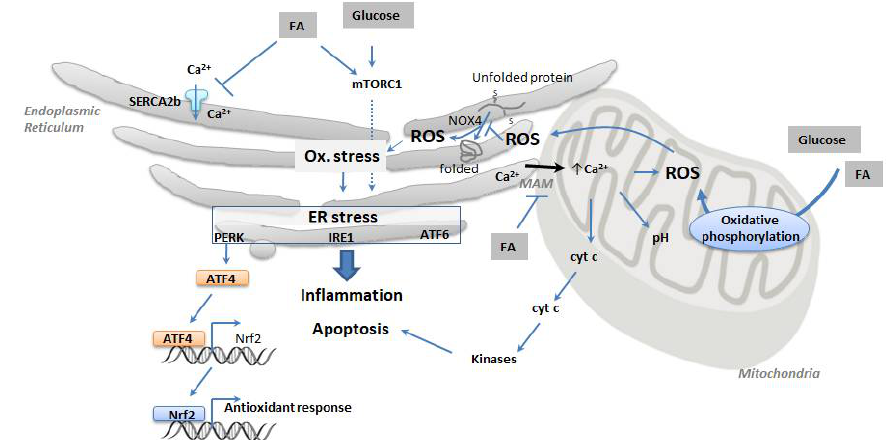
Figure 2. ER and the mitochondria function together as sensors of nutrient excess and integrators of the response to metabolic stress. Reactive oxygen species (ROS) are free radicals that are generated as a by-product of cellular metabolism from FA and glucose in the mitochondria. FA enhance MAM; thus, excessive cytoplasmic calcium enters in mitochondria and ER, triggering changes in mitochondrial pH and ROS production. This alters mitochondrial membrane potential and opens pores, thus releasing cytochrome c. Several calcium-dependent proteins and kinases are then activated, triggering apoptosis. ROS perturb the redox status of ER lumen and thus inhibit protein folding. The ER-associated protein NADPH oxidase 4 (NOX4) is implicated in ROS generation during disulfide bond formation for proper protein folding. Excess ROS cause oxidative stress, which induces the 3 branches of the UPR. The result of the UPR activation is inflammation and, upon sustained and/or intense stress, apoptosis. FA also disrupt SERCA activity and perturb ER calcium homeostasis. The mTORC1 complex is an important sensor of bioenergetic status and nutrient excess, and induces ER stress by unclear mechanisms. PERK-mediated activation of ATF4 induces NRF2, a transcription factor responsible for antioxidant cell response. Abbreviations: cyt c, cytochrome c (cyt c); Ox. stress, oxidative stress (Ox. Stress); MAM, mitochondria-associated membranes (MAM); mTORC1, mammalian target of rapamycin complex 1 (mTORC1); NOX4, NADPH oxidase 4 (NOX4); ROS, Reactive oxygen species (ROS); SERCA, sarco-endoplasmic reticulum Ca(2+)-ATPase (SERCA). Sharp arrows, activators; bar-ended arrows, inhibitors.